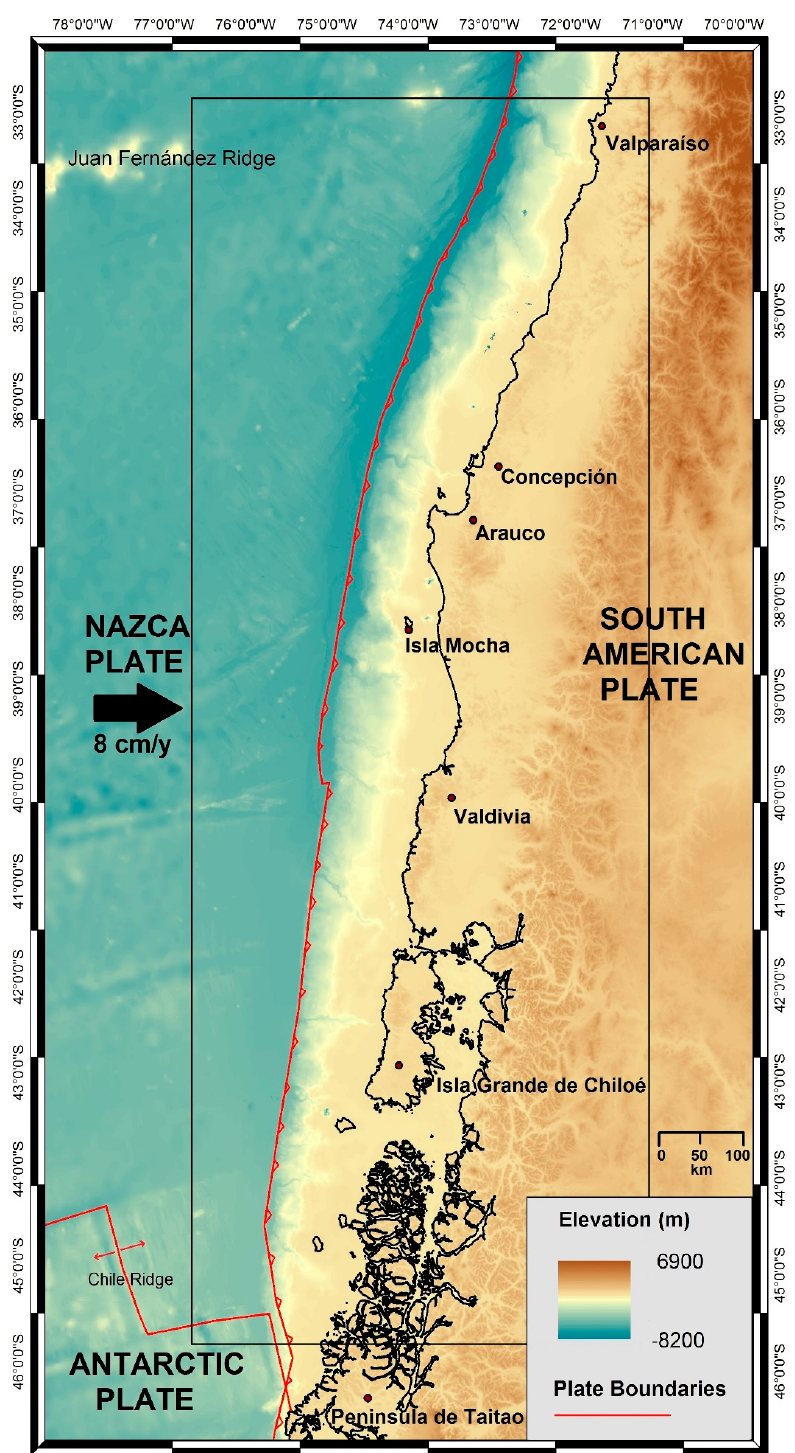
Figure 1. Topography and major tectonic elements of the study area. The black rectangle shows a sub-set of the study area selected for this work. The modelled area is the shelf-slope system, in which seafloor depths reach more than 500 m b.s.l.